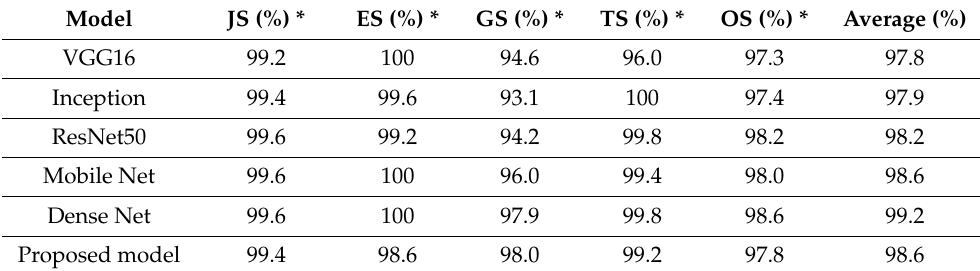
Table 4. Performance of different models for detecting the wheat growth stages.